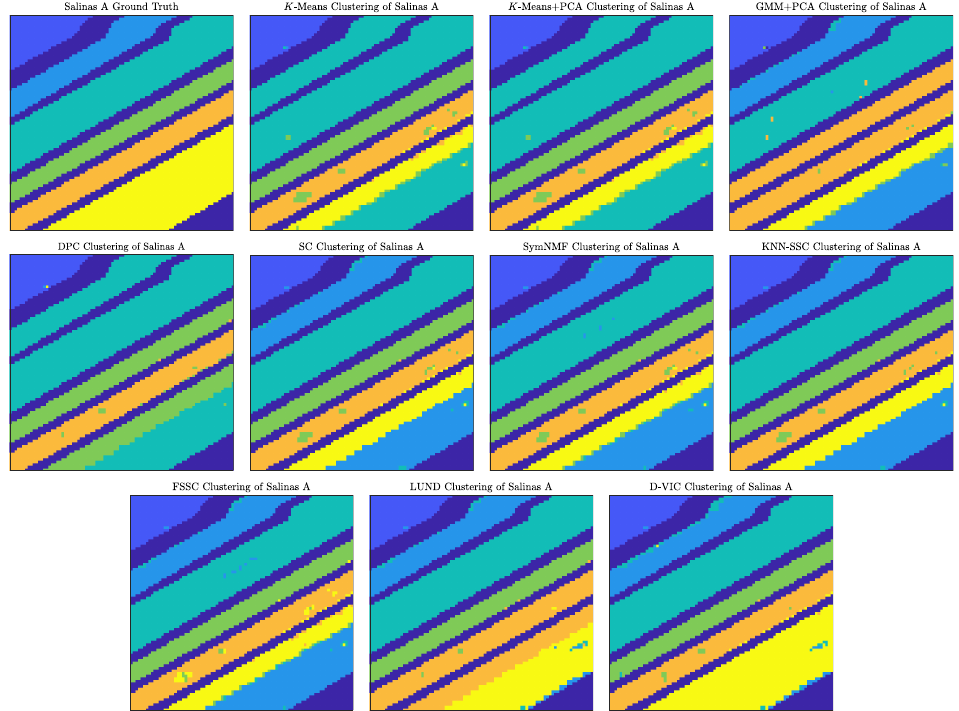
Figure 6. Comparison of clusterings produced by D-VIC and related algorithms on the Salinas A HSI. Unlike any comparison method, D-VIC correctly groups pixels corresponding to 8-week maturity romaine (indicated in yellow), resulting in the near-perfect recovery of the ground truth labels.